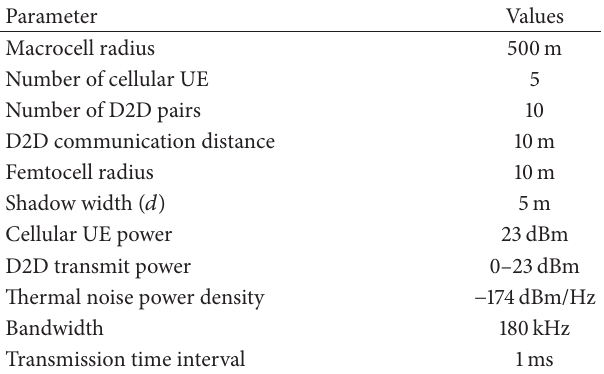
Figure 5: Macrocell BS rate distribution. Table 1: Simulation parameters and values.